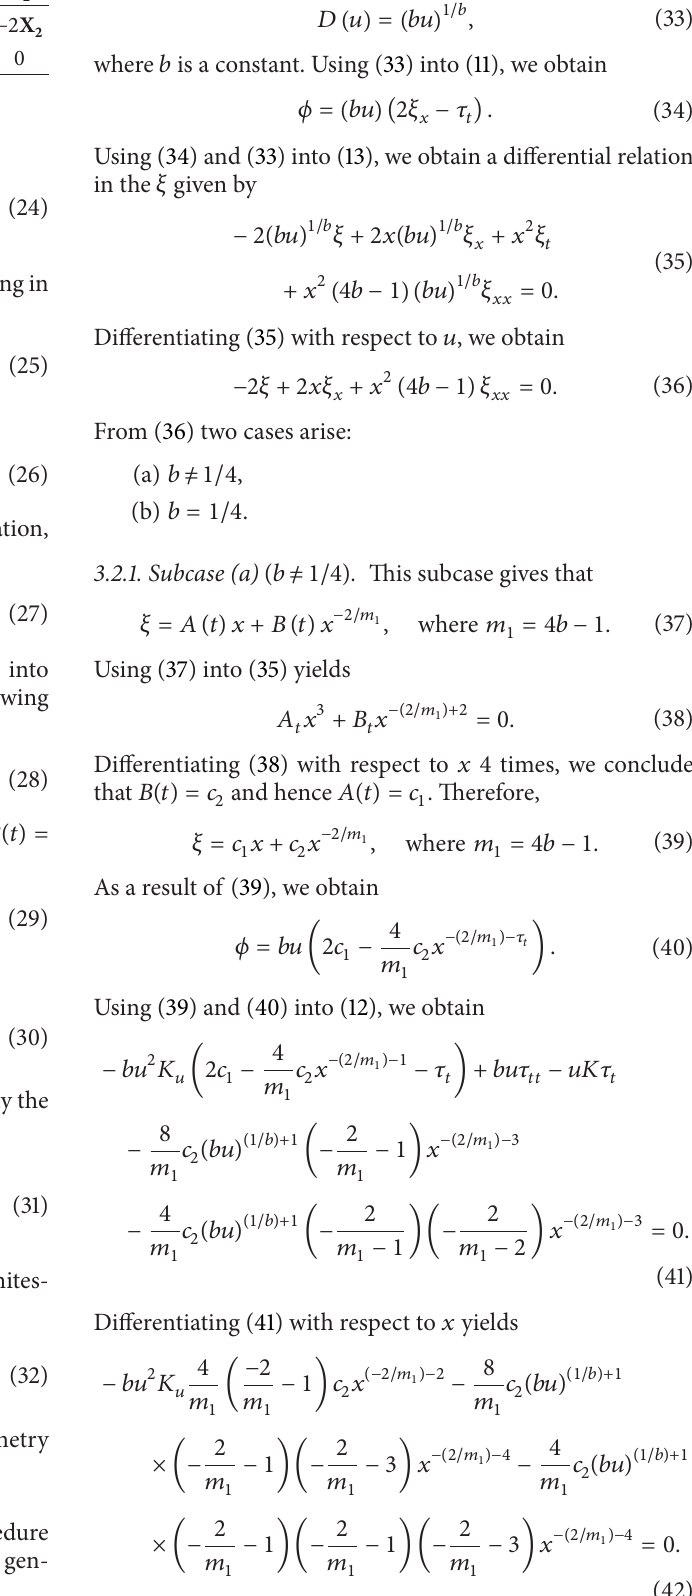
Table 1: Commutator table of the tumor equation. [ X , X i j